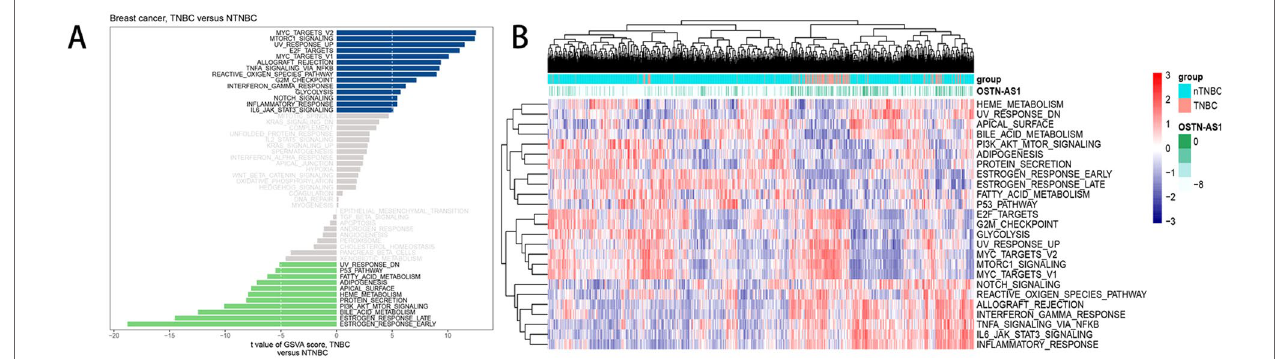
FIGURE 5 | GSVA analysis displaying pathway differences. (A) Differences in pathway activities scored by GSVA between TNBC and nTNBC subtypes. T values are shown from a linear model. We set | t | > 5 as a cutoff value. The blue column indicates activated pathways in TNBC, and the green column indicates activated pathways in nTNBC. DN, down; UV, ultraviolet; v1, version 1; v2, version 2. (B) The variation tendency between increasing expression of OSTN-AS1 and the degree of differentially expressed pathways.